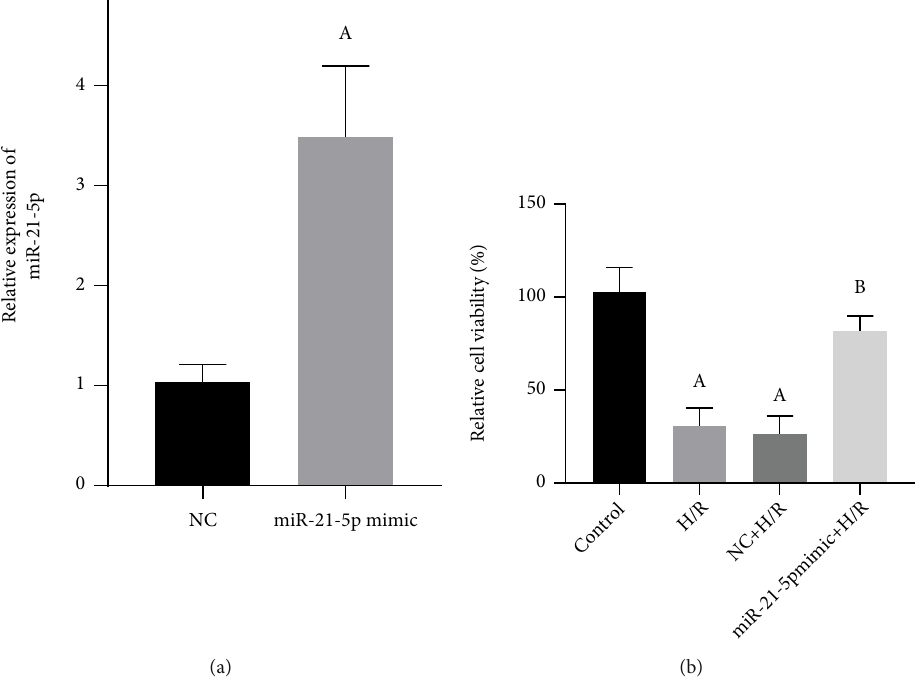
Figure 2: The e ff ect of miR-21-5p overexpression on H/R-induced cell damage ( n = 3 ). (a) Veri fi cation of the overexpression of miR-21-5p in cells transfected with miR-21-5p mimic. (b) The e ff ects of overexpression of miR-21-5p on cell viability in HT22 cells under H/R conditions. Note: Student ’ s t -test was used. Compared with the control group, a P < 0 : 05 ; compared with the H/R group, b P < 0 : 05 . Table 1: The e ff ects of miR-21-5p on SOD, MDA, and LDH activity of H/R-induced cells ( n = 3 , mean ± SD ).